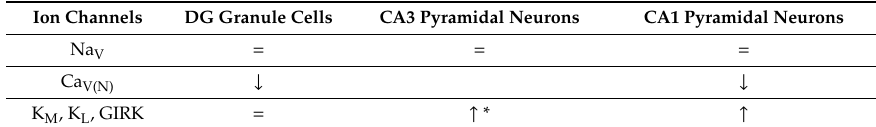
Table 2. Ion channels and their modulation by somatostatin ( ↑ : potentiation; ↓ : reduction; = no e ff ect) in the principal hippocampal neurons of the information line DG → CA3 →